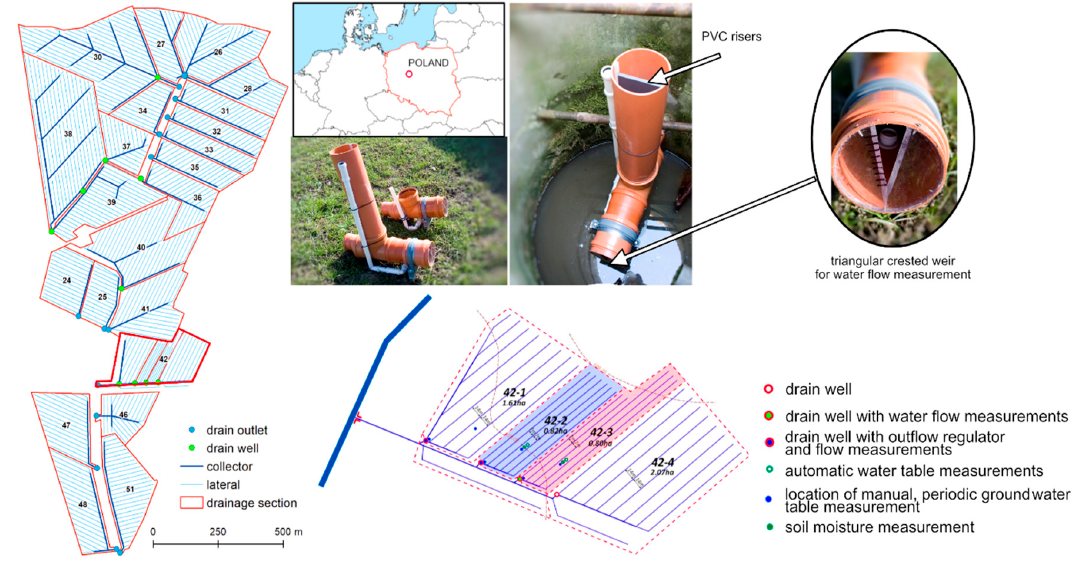
Figure 1. Study site description.